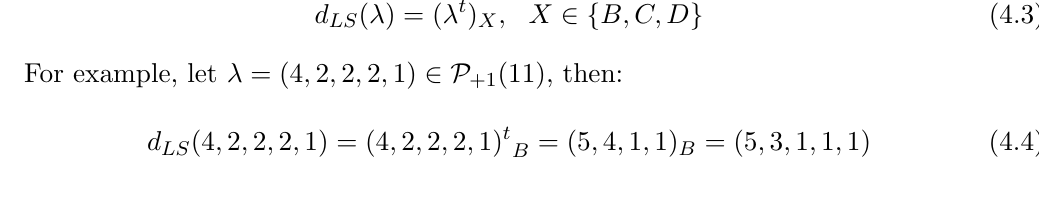
Figure 15. Diagram of the transpose partition (cid:21) t = (4 ; 2 ; 2 ; 2 ; 1) t = (5 ; 4 ; 1 ; 1) after re(cid:13)ecting through the